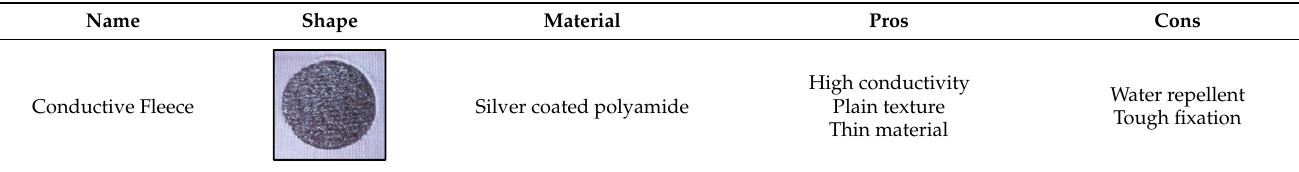
Table 2. Name, pros, and cons of the skin-electrode interface materials.